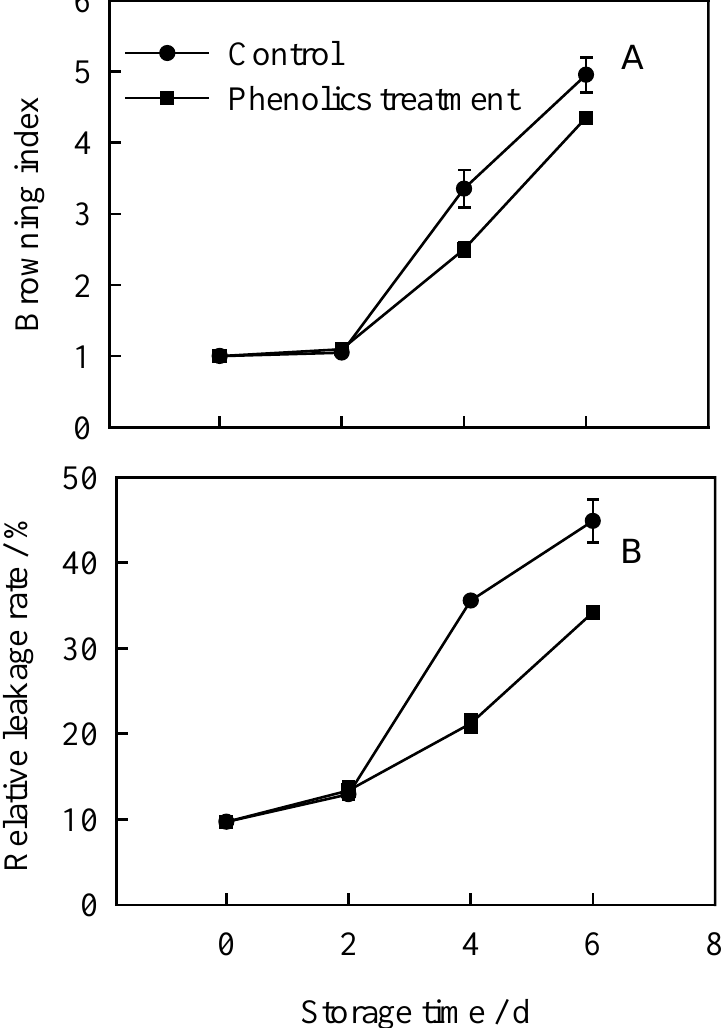
Figure 7. Effect of exogenous phenolics on pericarp tissues browning (A) and relative leakage rate (B) of litchi fruit during storage at 28 °